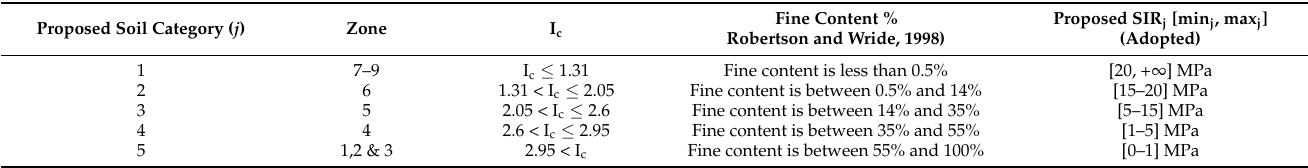
Table 2. Proposed Soil category and maximum improvement (Robertson, 2009 and Robertson and Wride,